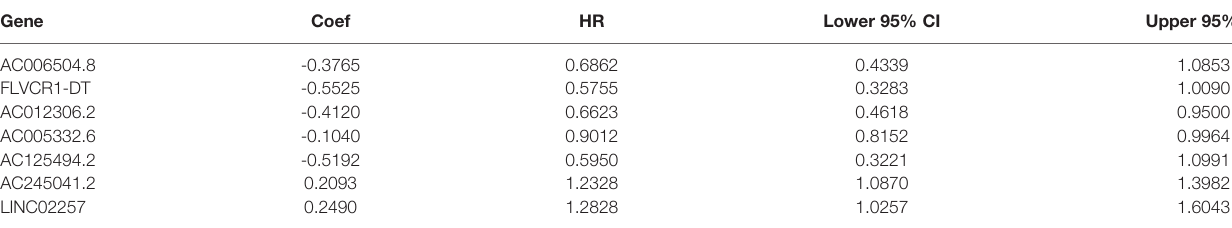
TABLE 2 | Multivariate cox regression analysis of prognostic autophagy- associated gene. Gene